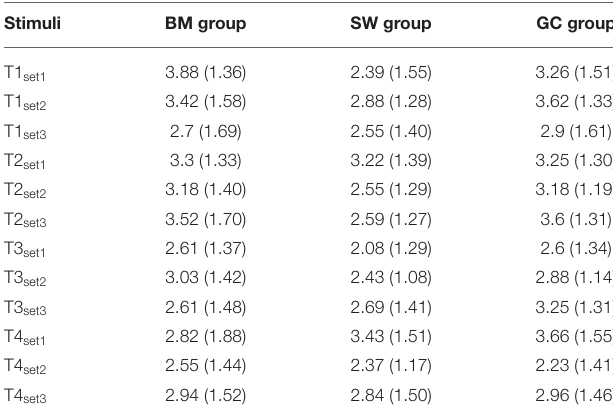
TABLE 4 | Means for tone height description accuracy with standard deviation in parentheses. Stimuli